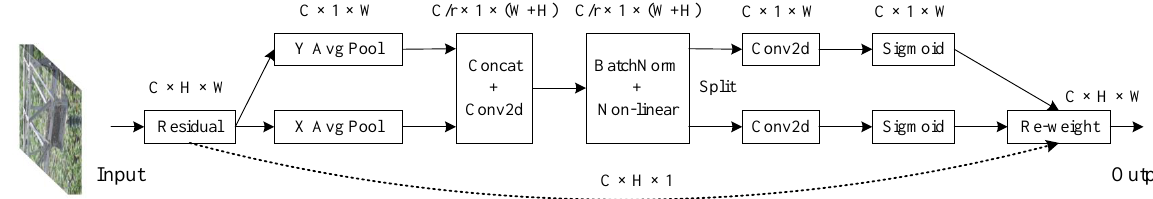
Figure 8. The structure of the coordinate